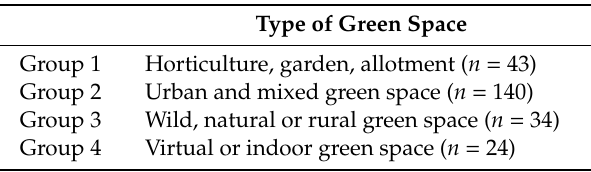
Table 2. The literature was divided into thematic groups based on the type of GS investigated (literature reviews are not included).